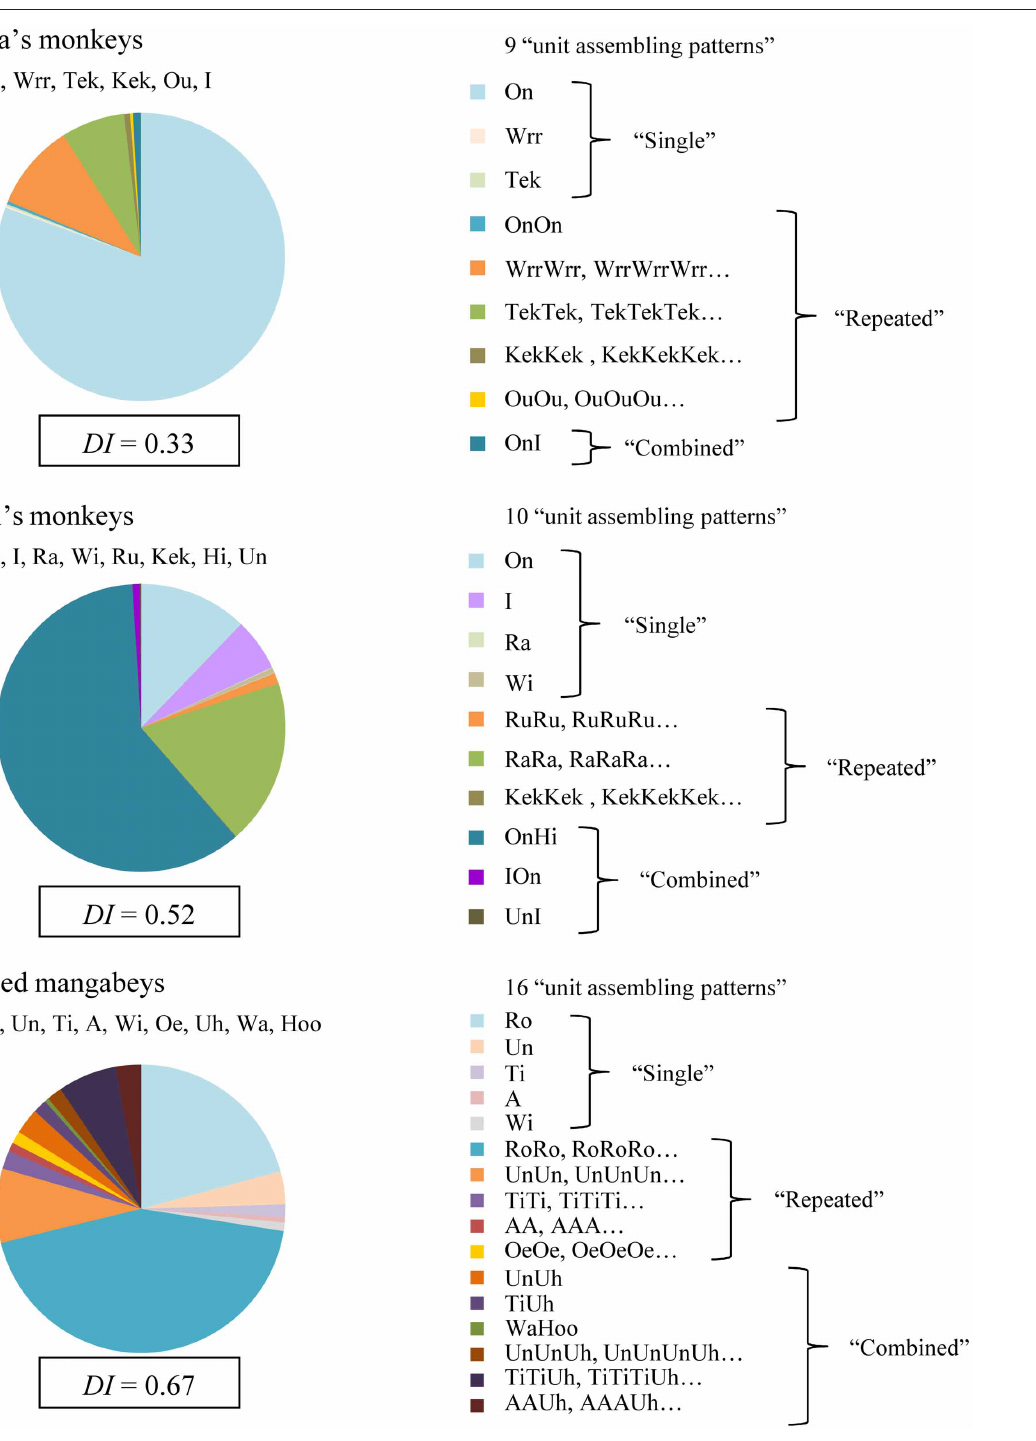
FIGURE 4 | Relative proportion of the different “unit assembling patterns” produced by each of three species of primate. Below the species’ name: number and name of unit types. Unit types are labeled as in previous publications for De Brazza’s monkeys (Bouchet et al., 2012b) and red-capped mangabeys (Bouchet et al., 2010). Campbell’s monkeys’ repertoire, however, has been revised according to Bouchet et al. (2010) multi-level approach; the correspondence between this nomenclature and the call type names used in Lemasson and